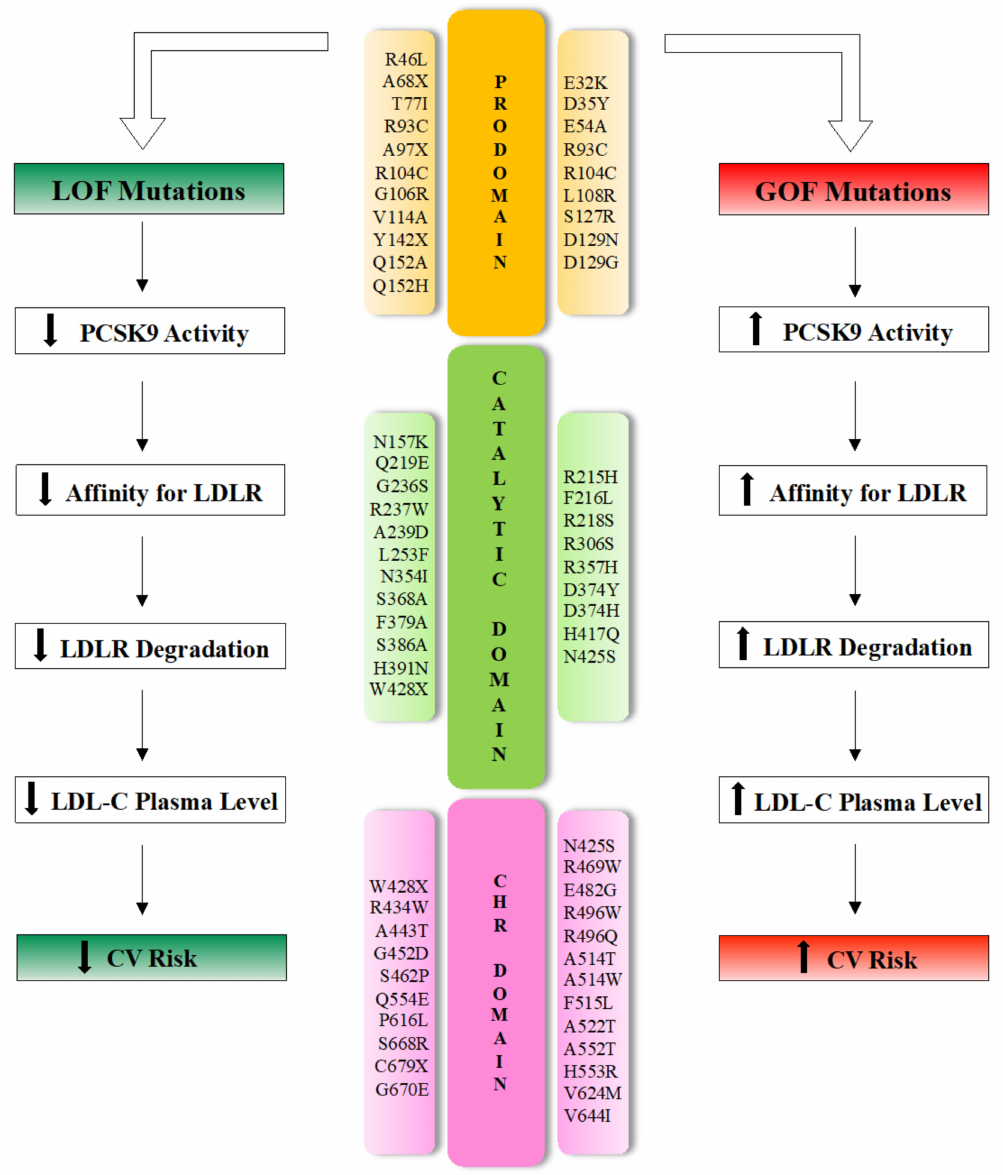
Figure 3. Effects of the main natural mutations of the PCSK9 domains on cholesterol homeostasis phenotype and their impact on cardiovascular disease risk. LOF: loss-of-function; GOF: gain-of-function; LDL: low-density lipoprotein; LDLR: LDL receptor; LDL-C: LDL cholesterol; CV: cardiovascular; CHR: cysteine- and histidine-rich